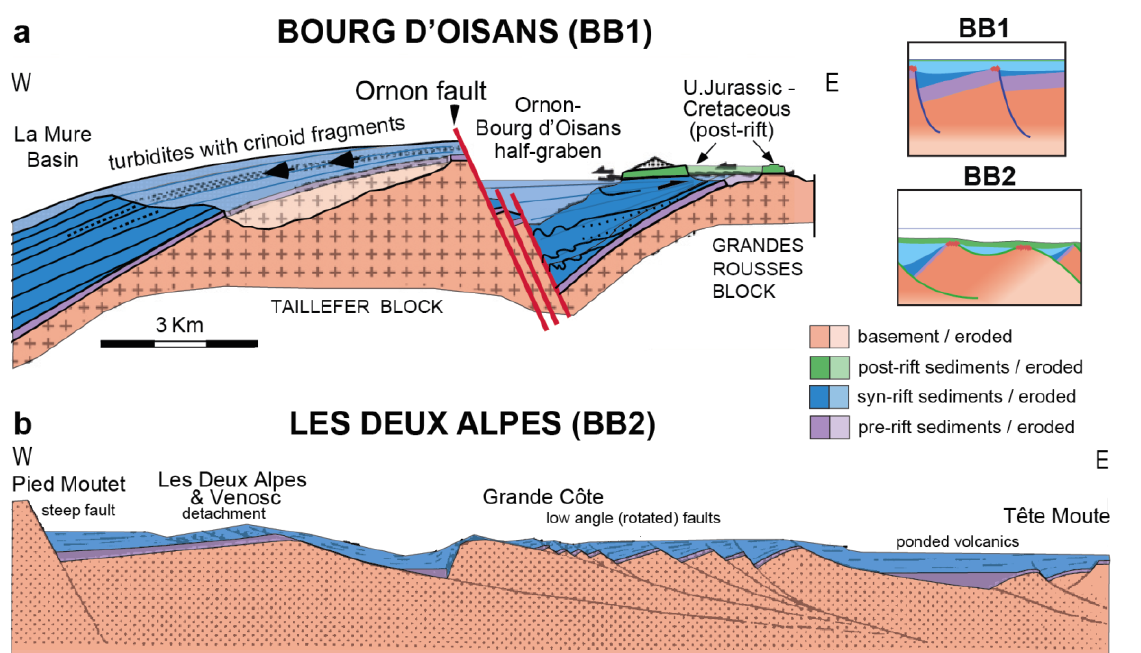
Figure 6. Examples of BB1 and BB2 in the Western Alps: ( a ) in the external Oisans, the Bourg d’Oisans Basin represents a half graben of the former European proximal margin and is typically a BB1 (figure modified from [71]); ( b ) in our study area, the Les Deux Alpes–La Muzelle region belongs to the internal part of the Oisans Massif. It displays relics of low-angle extensional detachment faults that exhumed the basement to the seafloor and is therefore interpreted as a BB2 (see text for details and discussion; figure modified from [78]).